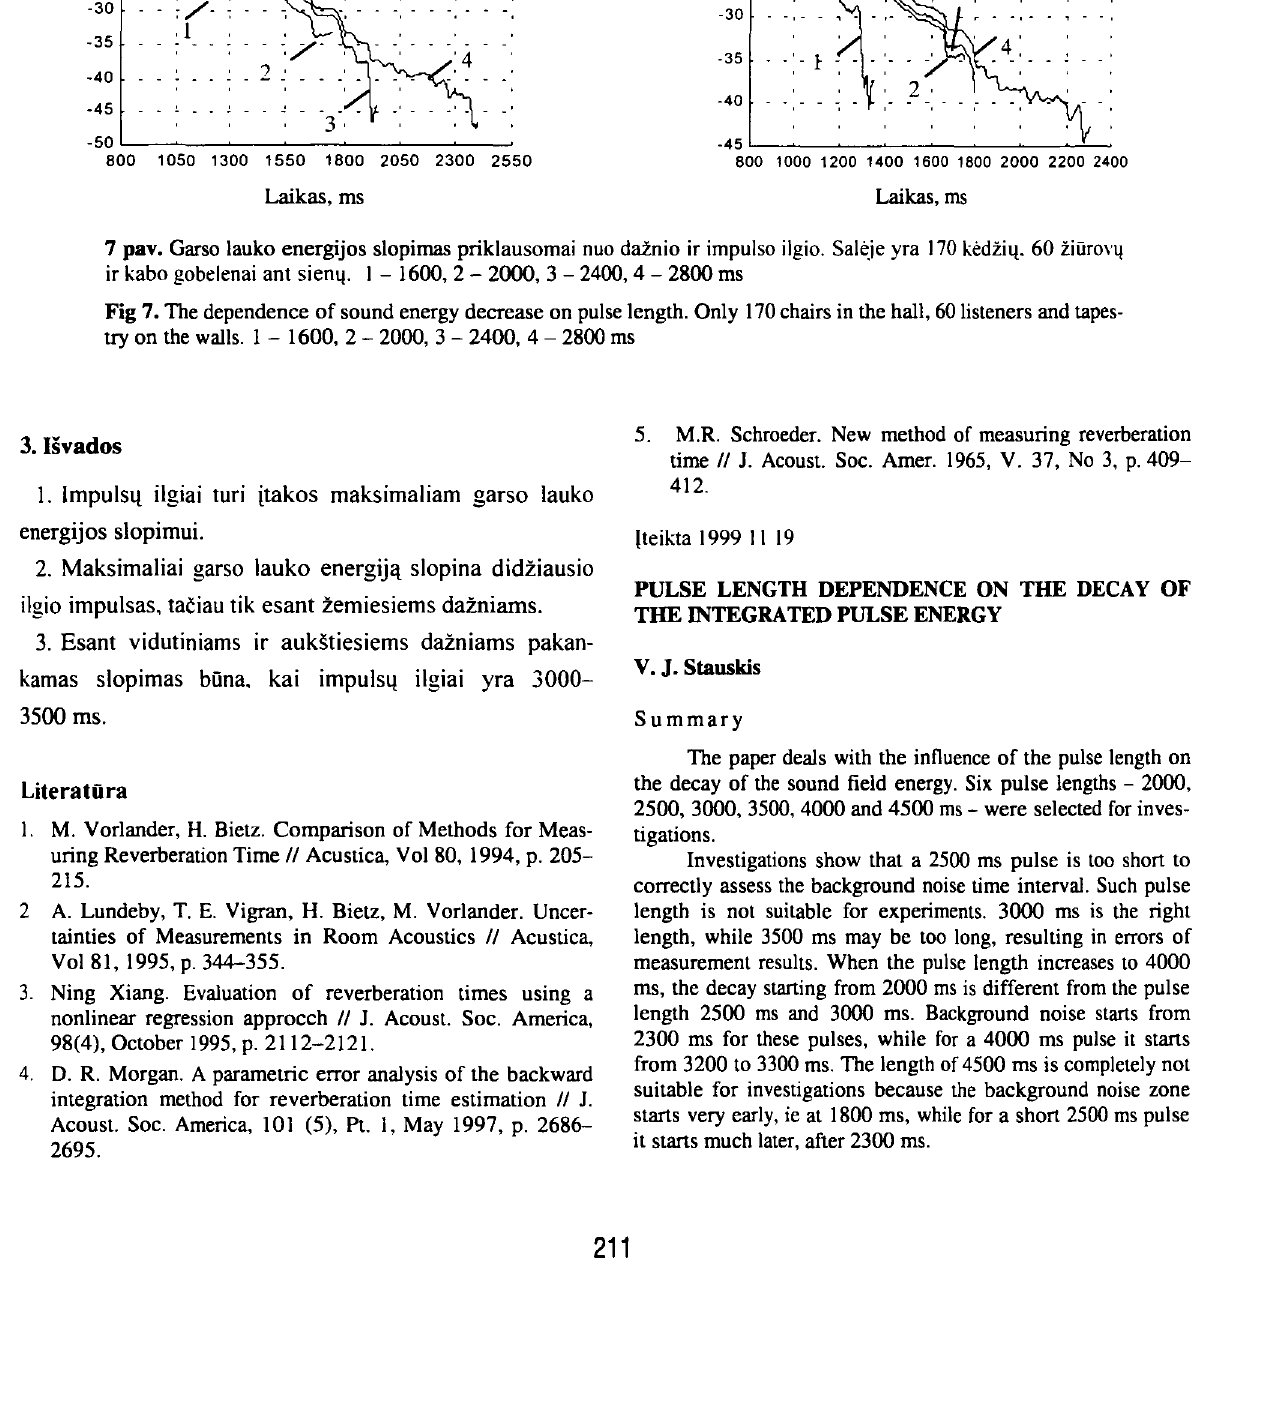
Fig 7. The dependence of sound energy decrease on pulse length. Only 170 chairs in the hall, 60 listeners and tapes try on the walls. I - 1600, 2 - 2000, 3 - 2400, 4 - 2800